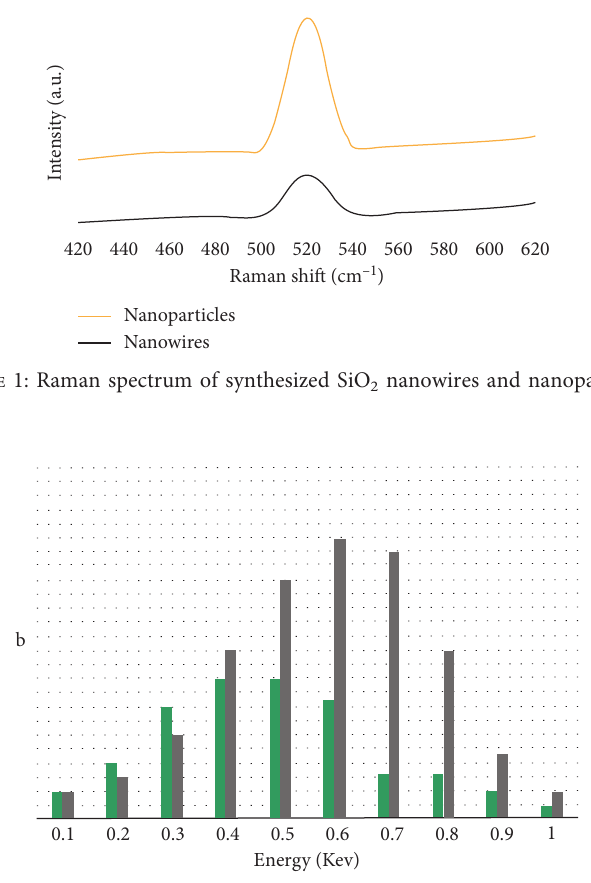
Figure 2: EDX spectrum of the synthesized